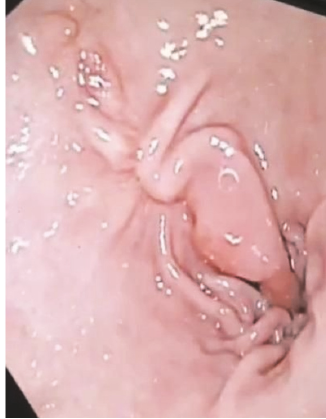
Figure 4: Near complete resolution of the mass with minimal scarring and residual tissue at the site on six-week follow-up